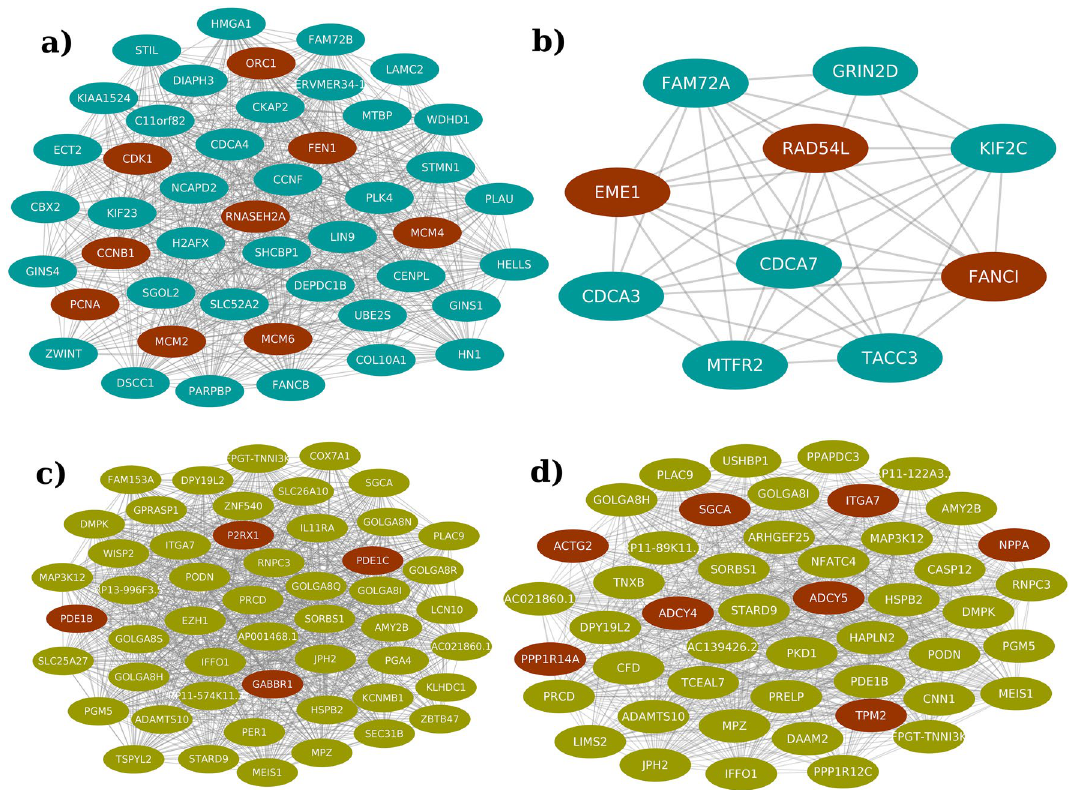
Figure 4. Network representing the projected up and downregulated clusters. Ellipse shaped nodes represents the members of cluster. (Blue nodes—upregulated and green nodes—downregulated and brown nodes— proteins involved in respective pathways) ( a ) Cluster-16 (up), cell cycle, cellular senescence and DNA replication pathways. ( b ) Cluster-84 (up), Fanconi anemia and Homologous recombination pathways. ( c ) Cluster-28 (down), Calcium signaling and sensory transduction pathways. ( d ) Cluster-74 (down), Vascular smooth muscle contraction, dilated and Hypertrophic cardiomyopathy